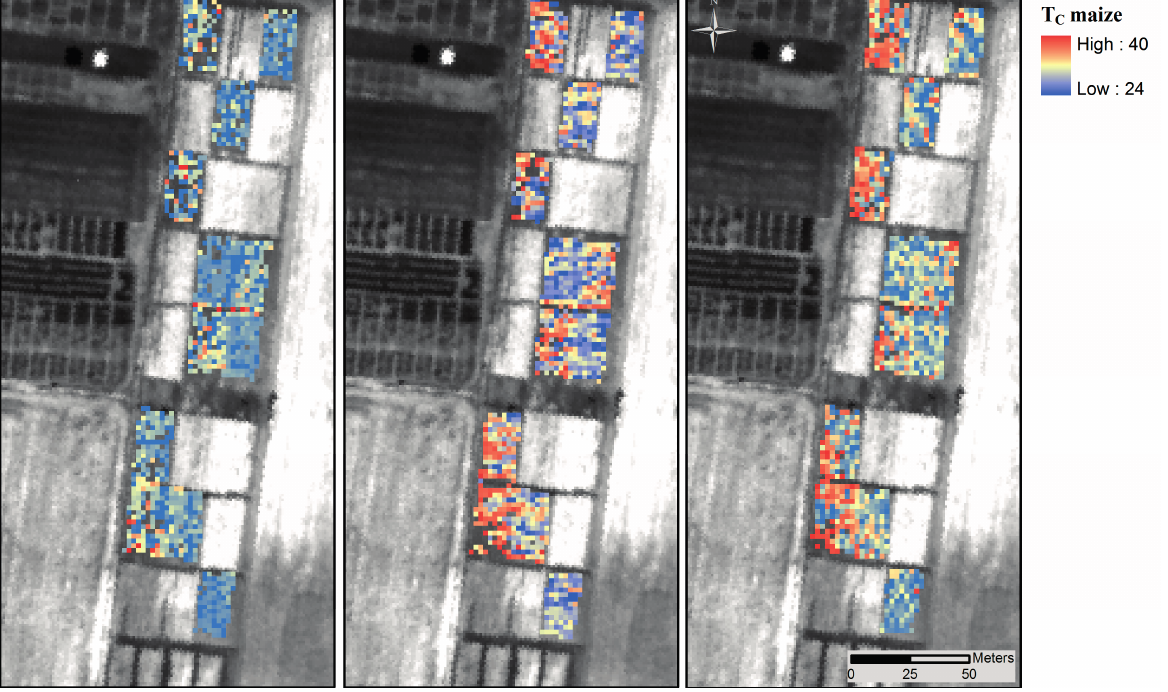
Figure 4. Maps of canopy temperature in maize plots during the morning ( left ), at midday ( center ) and during the afternoon ( right ). The corresponding Ta at the time of the overpasses were 26.2, 28.6 and 29.9 °C, respectively.